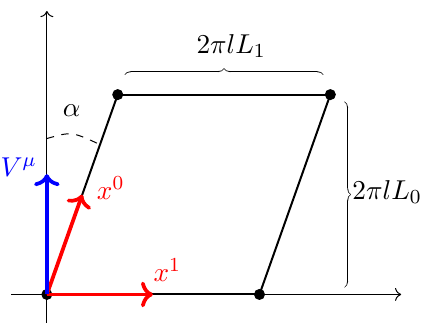
Figure 1 . The flat torus parametrised by the coordinates x 0 , x 1 , in red. In blue, the time-like vector that will be used to perform the Wick